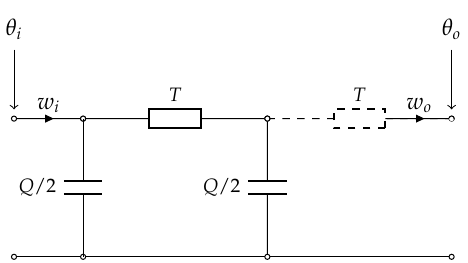
Figure 6. Thermal analogy for